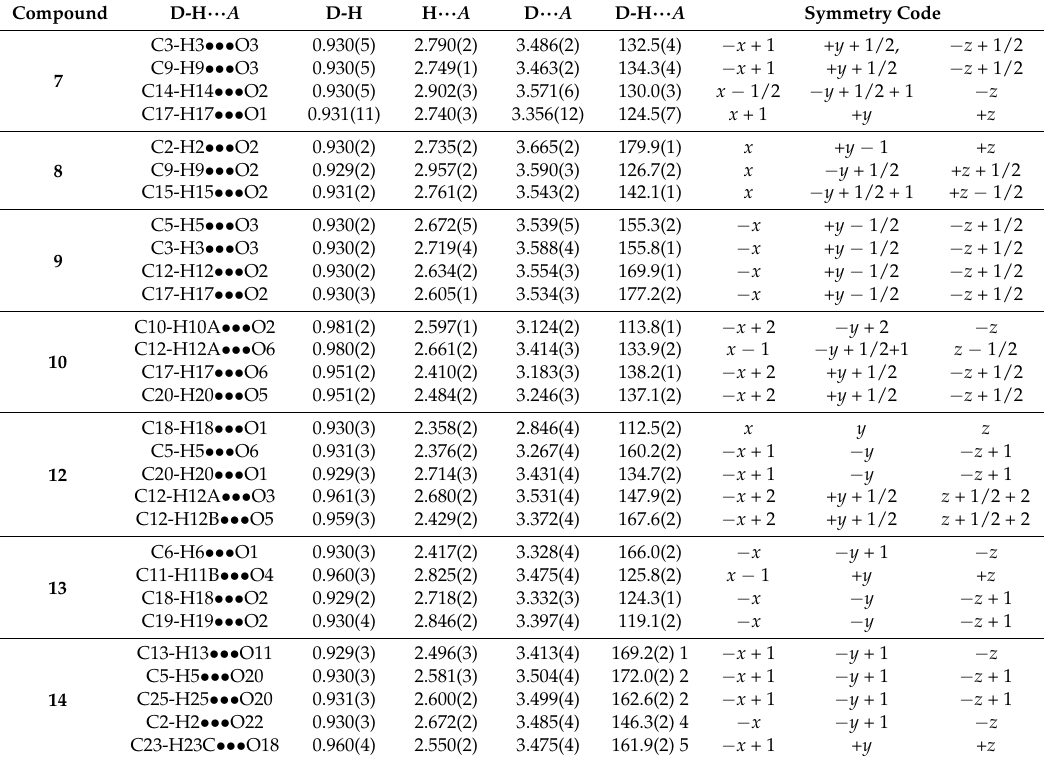
Table 2. Geometry of the hydrogen bonding interactions (Å, ◦ ) for compounds 7 , 8 , 9 , 10 , 12 , 13 , and 14 .